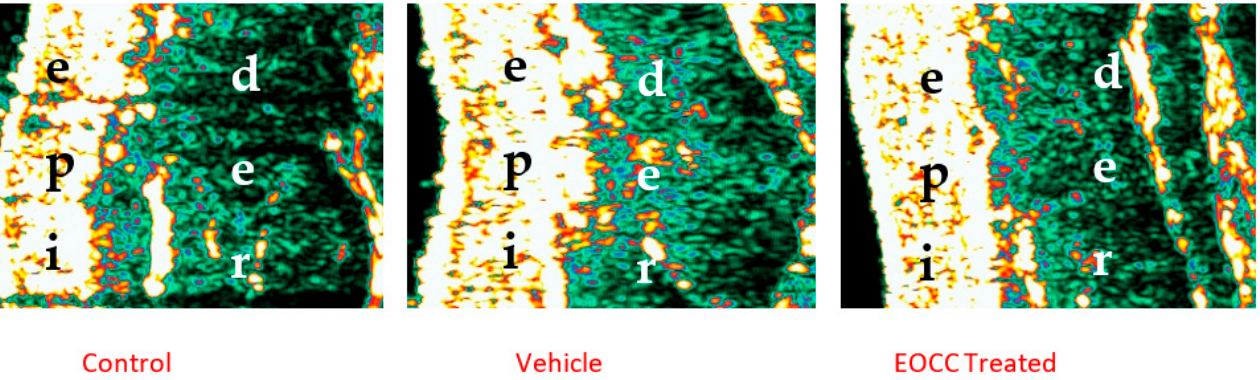
Figure 1. Illustrative ultrasound images of the effects of EOCC formulation on the skin 30 min after MN application. Observed are an increase in epidermal echogenicity area (bright area) and a decrease in edema (black area) in EOCC-treated site; “epi” (epidermal layer) while in the “der”